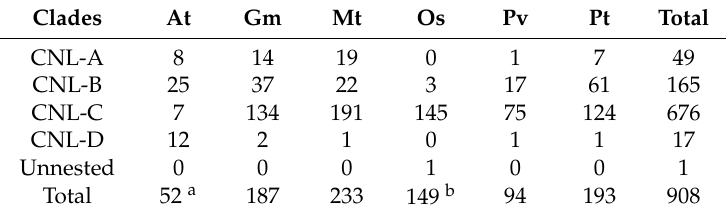
Table 2. Distribution and diversity of nTNL (non-Toll interleukin receptor, nucleotide-binding site, eucine-rich repeat) genes in six different plant species (At = Arabidospis thaliana , Gm = Glycine max , Mt = Medicago truncatula , Os = Oryza sativa , Pv = Phaseolus vulgaris and Pt = Populus trichocarpa). Clades At Gm Mt Os Pv Pt Total CNL-A 8 14 19 0 1 7 49 CNL-B 25 37 22 3 17 61 165 CNL-C 7 134 191 145 75 124 676 CNL-D 12 2 1 0 1 1 17 Unnested 0 0 0 1 0 0 1 Total 52 a 187 233 149 b 94 193